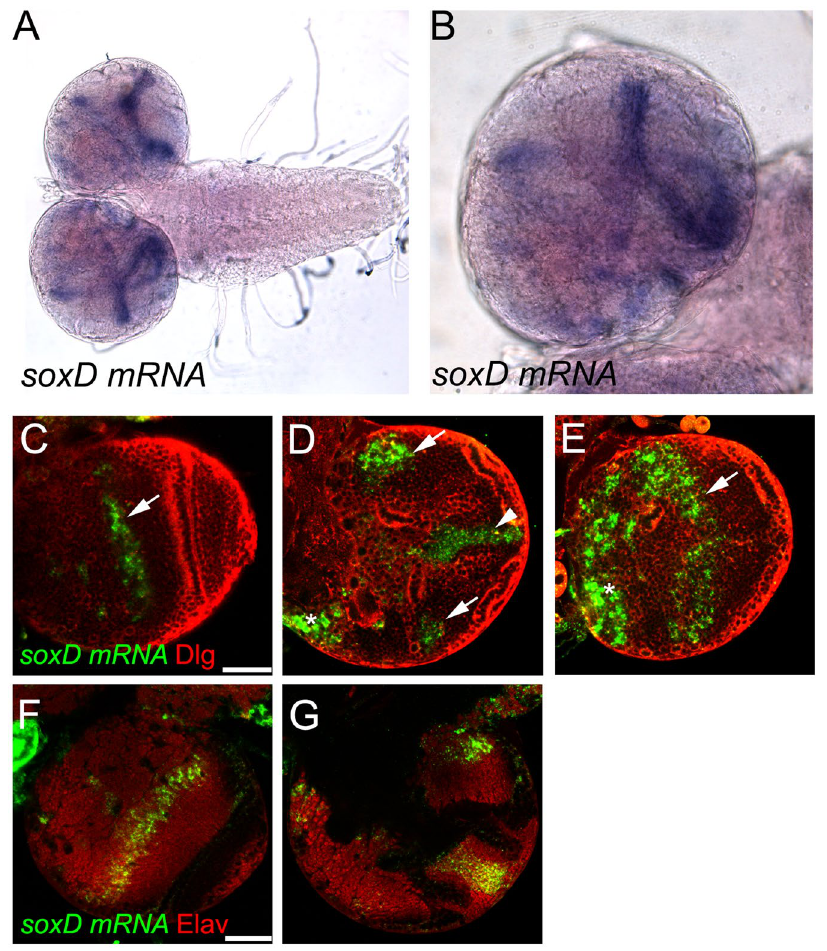
Figure 2. soxD is expressed in the larval optic lobe. ( A , B ) Larval brain in situ hybridisation using a specific probe against soxD . ( C–E ) Fluorescent in situ hybridisation of larval brain for soxD (green) and co-stained with antibody against Discs large (Dlg, red), different sections in the antero-posterior axis. ( F , G ) Fluorescent in situ hybridisation of larval brain for soxD (green) and co-stained with anti-Elav (red), different sections in the antero-posterior axis. Arrows show signal in the medulla, while arrowheads show signal in the lobula complex. Scale bars are 50 µ